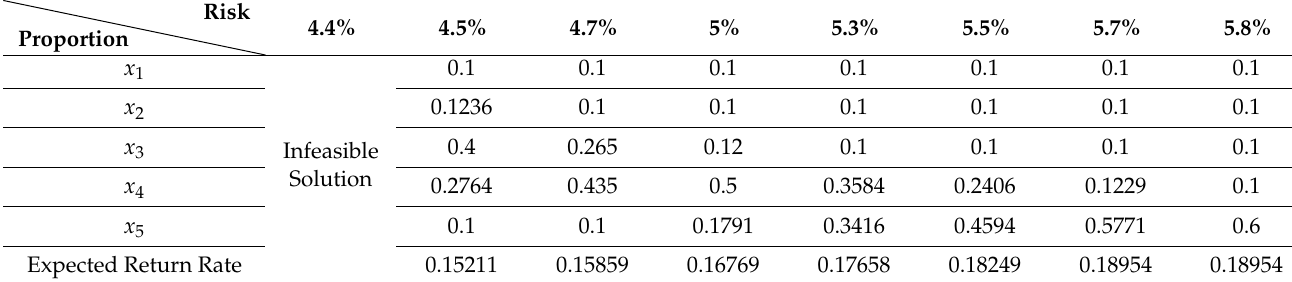
Table 1. The efficient portfolio with s = 2 in a guaranteed return rate (cid:101) p 1 .